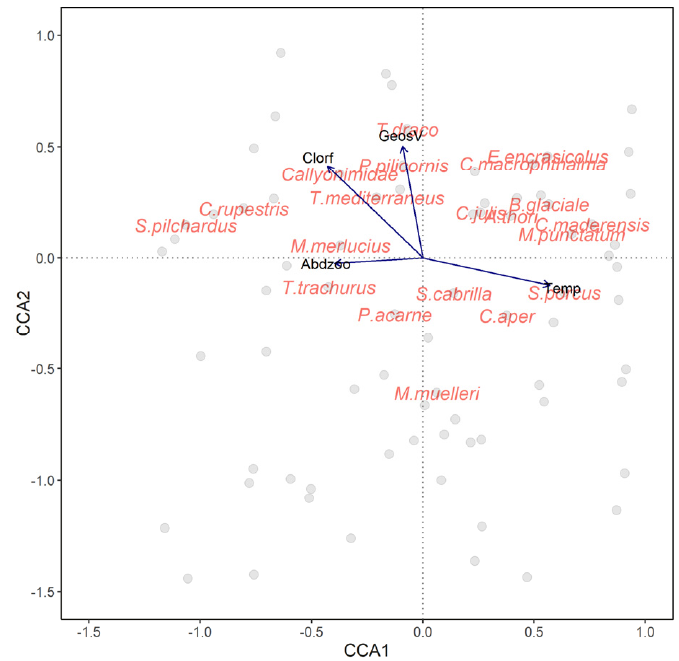
Figure 9. Canonical correspondence analysis (CCA) biplot for the environmental variables (arrows),